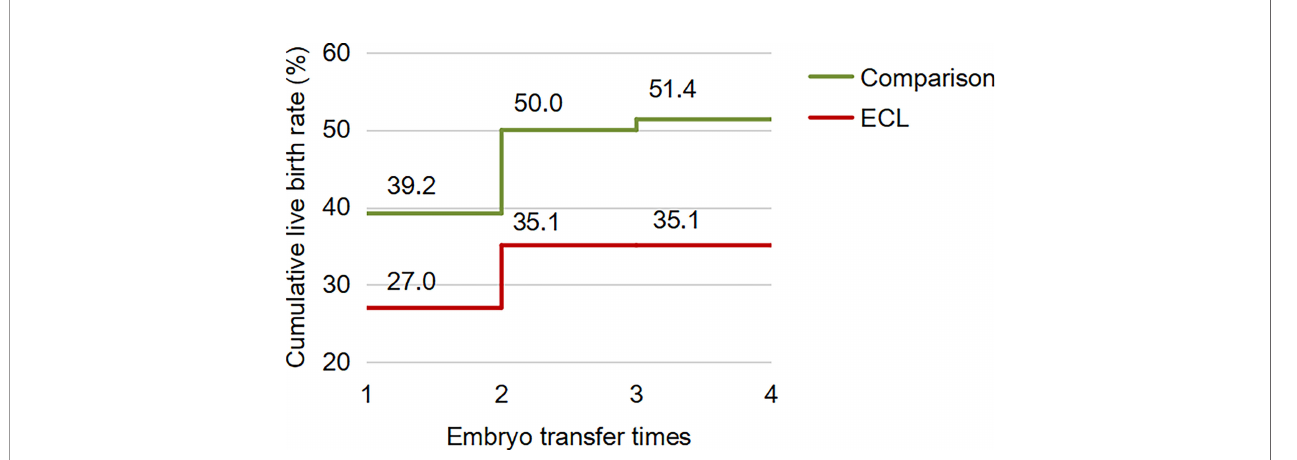
FIGURE 1 | The CLBR following every embryo-transfer procedure for the fi rst complete cycle. For each complete cycle, the LBR following every embryo-transfer procedure rose from 27.0% to 35.1% in the ECL group (red line), and from 39.2% to 51.4% in the comparison group (green line). The difference between the two groups was not signi fi cant (P=0.113).